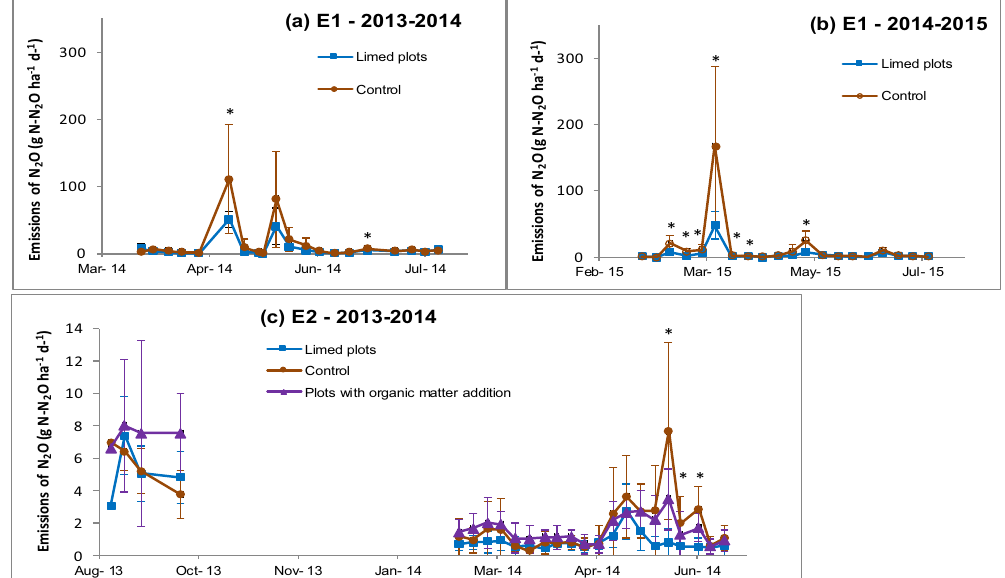
Figure 3. In situ N 2 O emissions measured (mean and standard deviations obtained from the 9 replicates per treatment) in E1 (upper panel) and E2 (lower panel). * Indicates significant (p < 0.05) differences for results obtained on limed plots and control ones. In E1, liming events were of 1 t CaO applied in September 2013 and 2014. Nitrogen fertiliser was spread on 14/05/2014 (60 kg of N ha − 1 ) and on 09/03/2015 (70 kg of N ha − 1 ), on 30/03/2015 (50 kg of N ha − 1 ), and on 1 0/05/2015 (60 kg of N ha − 1 ). In E2, liming event was of 1.5 t CaO in September 2013 and organic matter was applied at the same date. Mineral fertilisers were spread on 2/05/2014 (50 Kg N ha − 1 ) and on 9/05/2014 (50 Kg N ha − 1 ). The “pig manure” plots did not receive the second